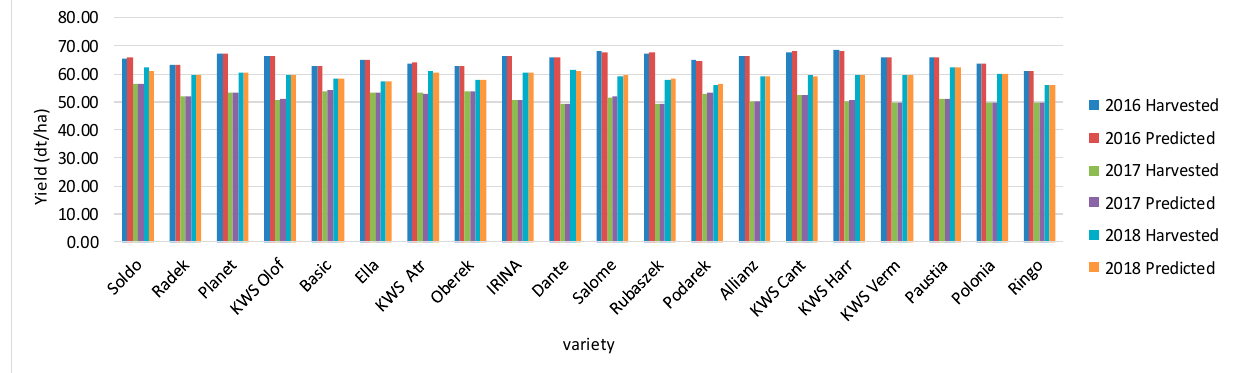
Figure 5. Comparison between forecasted yield (dt/ha) of 20 varieties using AGRO-SBY model with harvested yield (dt/ha) in 2016, 2017, and 2018 based on the average in thirteen environments. Estimated model parameter values, standardized parameter values, and